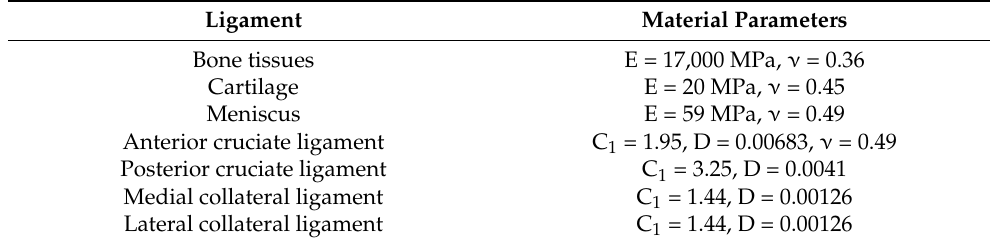
Table 1. Material parameters of the